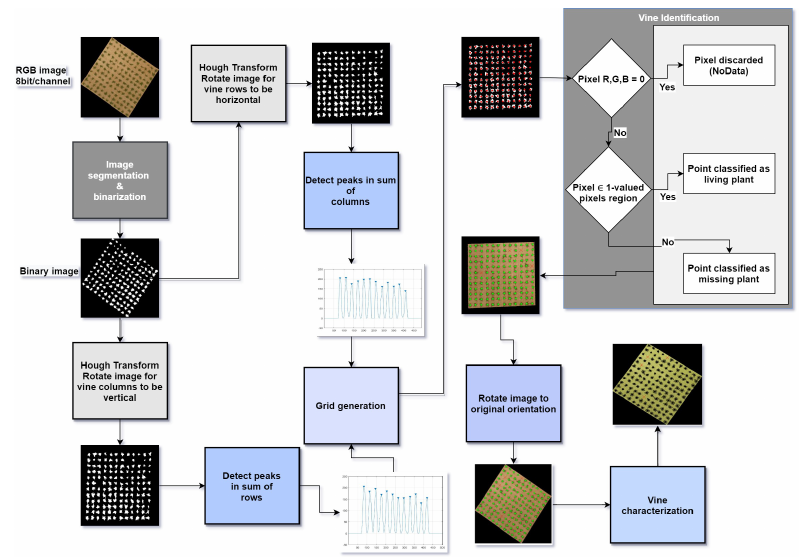
Figure A1. Proposed method